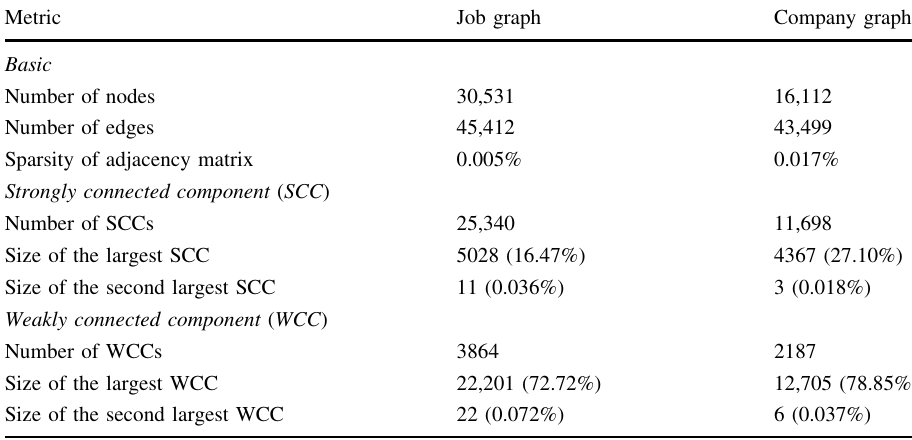
Table 7 Network statistics of the Singapore dataset